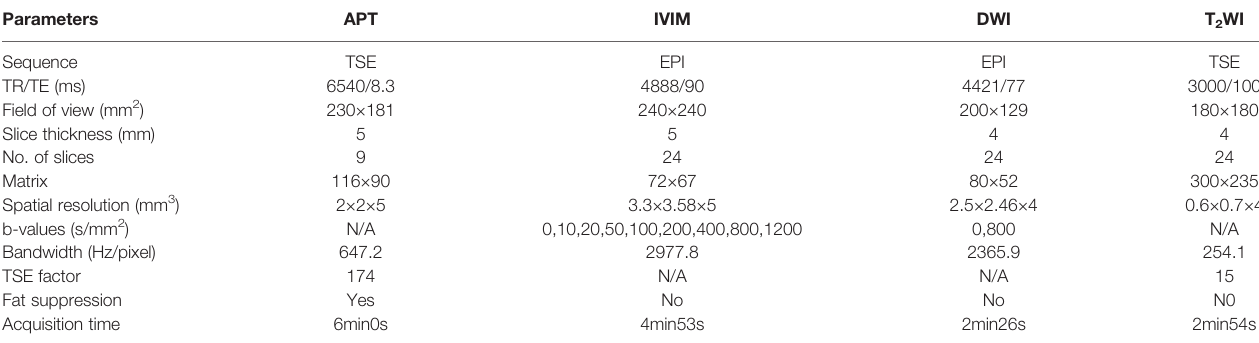
TABLE 1 | MRI acquisition parameters. Parameters